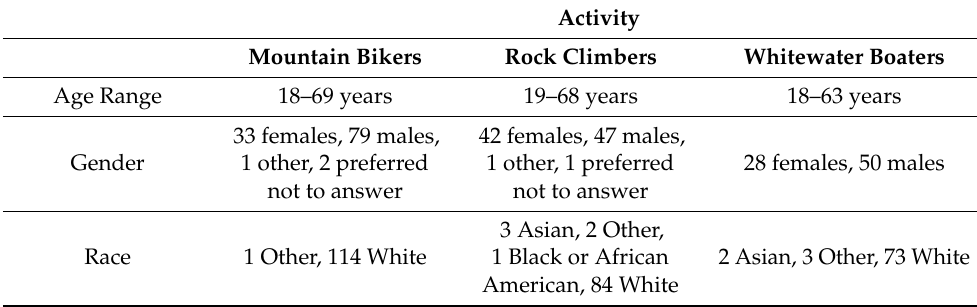
Table 3. Participant demographic